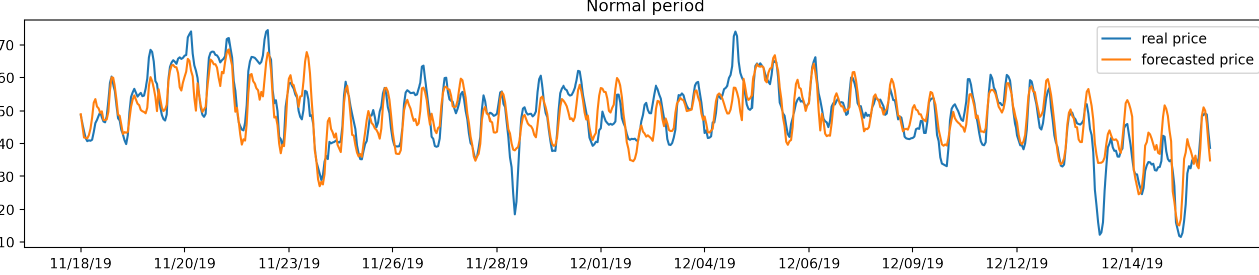
Figure 7. Comparison between actual and predicted price by model CNN using validation data for the normal data period.